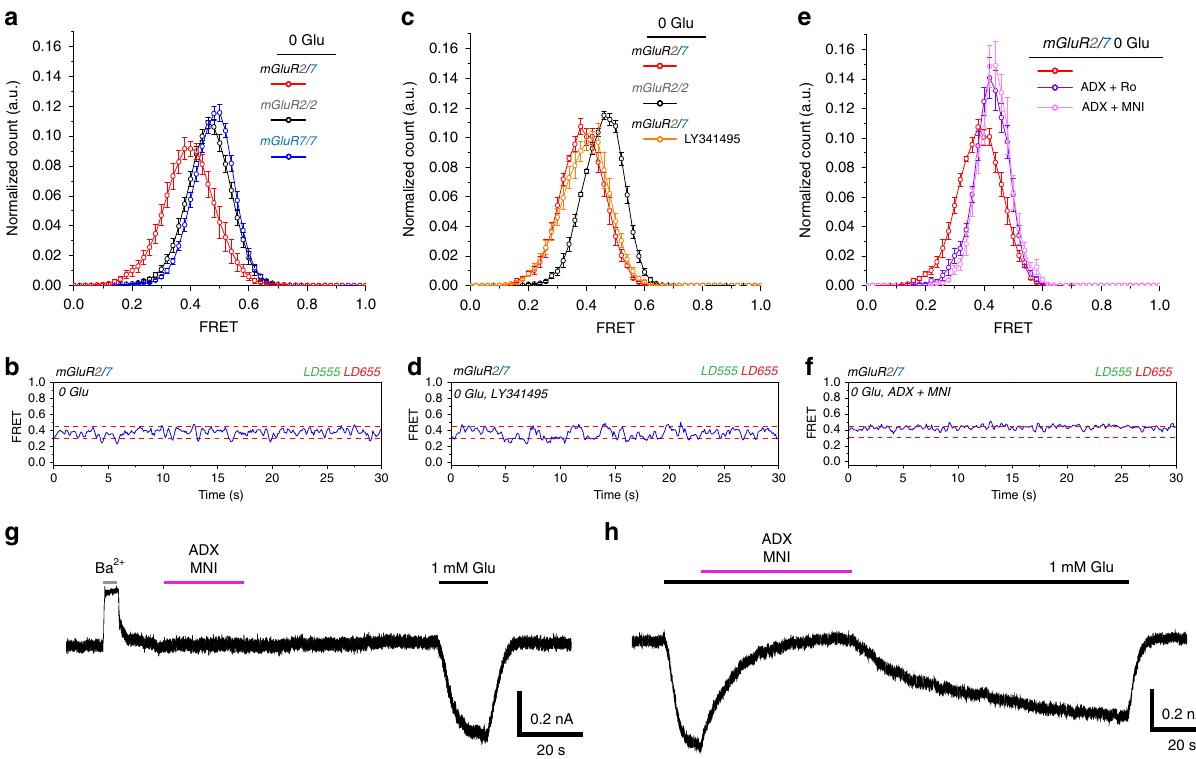
Fig. 6 Spontaneous conformational rearrangements of mGluR2/7 in the Apo state. a , b 0 glutamate smFRET histograms of SNAP-mGluR2/SNAP-mGluR2, SNAP-mGluR7/SNAP-mGluR7 and CLIP-mGluR2/SNAP-mGluR7 show a shift to lower FRET values in mGluR2/7 ( a ), associated with spontaneous transitions to an intermediate FRET state of ~0.3. c , d The left shift of the 0 glutamate CLIP-mGluR2/SNAP-mGluR7 (5 movies, 191 molecules, s.e.m. error bars) smFRET histogram relative to that of SNAP-mGluR2/SNAP-mGluR2 (6 movies, 257 molecules, s.e.m. error bars) ( c ) and the spontaneous transitions to the intermediate FRET state ( d ) are not altered by 100 µ M of the orthosteric antagonist LY341495 in 0 glutamate (5 movies, 230 molecules, s.e.m. error bars). e , f The left shift of the 0 glutamate CLIP-mGluR2/SNAP-mGluR7 smFRET histogram ( e ) and the spontaneous transitions to the intermediate FRET state ( f ) are blocked by combined negative allosteric modulators for mGluR2 (either 11 µ M Ro-5229 (6 movies, 160 molecules, s.e.m. error bars) or 1.2 µ M MNI-137 (6 movies, 154 molecules, s.e.m. error bars)) and mGluR7 (125 µ M ADX 71743) in 0 glutamate. a – f BC-DY-547 or BG-DY-547 (donor) and BG- Alexa-647 (acceptor) imaged at 10 Hz. g , h Whole cell patch clamp recording (V h = − 60 mV; [K + ] in = [K + ] out = 150 mM) in HEK293T cells co- expressing mGluR2, mGluR7 and the GIRK1(F137S) channel have basal inward current, which is reversibly inhibited by the GIRK pore blocker Ba 2 + , but not affected by the combined negative allosteric modulators for mGluR2 (1 µ M MNI-137) and mGluR7 (3 µ M ADX 71743) ( g ), even though these are suf fi cient to completely block activation by 1 mM glutamate ( h